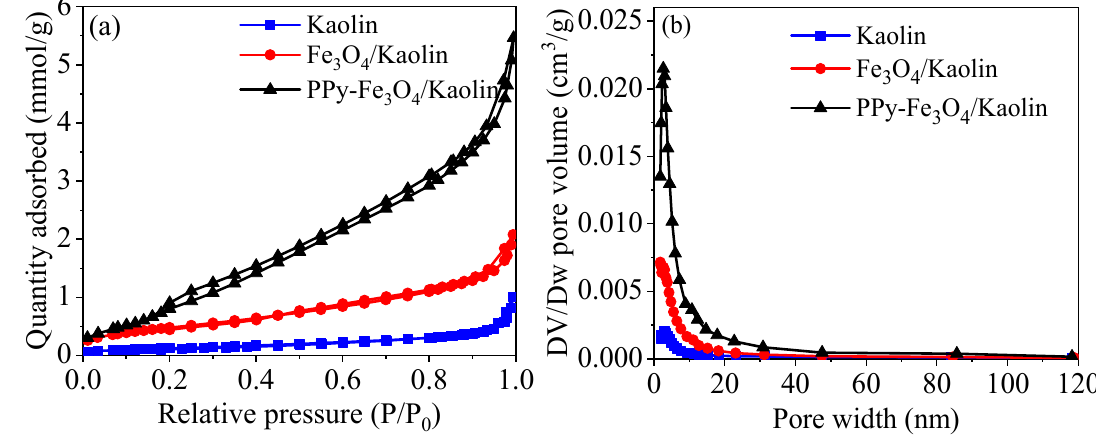
Figure 3. ( a ) N 2 adsorption-desorption plot and ( b ) pore distribution plot.